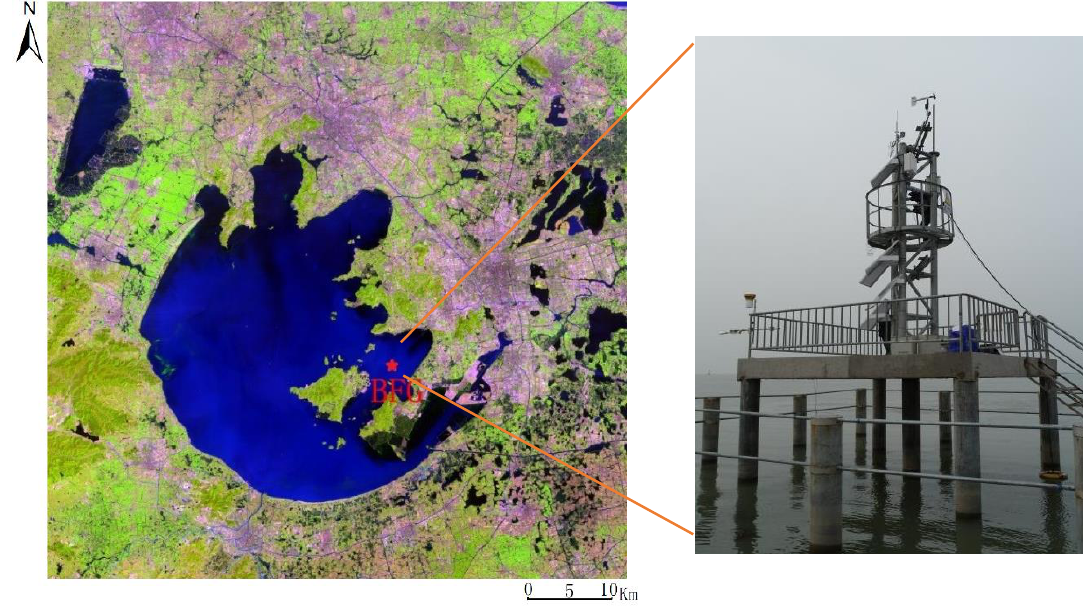
Figure 1. Locations of Lake Taihu and observation platform, BFG .